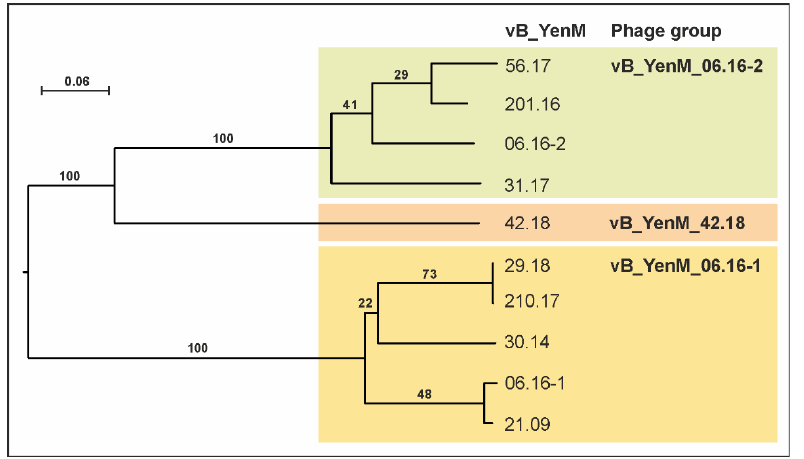
Figure 2. Phylogenomic GBDP tree of the temperate phages analysed in this study. Based on the phylogenomic GBDP tree of the phage genomes, seven species, two genera clusters and two family clusters were predicted. The numbers above branches are pseudo-bootstrap support values from 100 replications. The branch lengths are scaled in terms of the respective distance formula (formula D6; average support of 82%) used. The predicted branches are colored according to the assigned phage